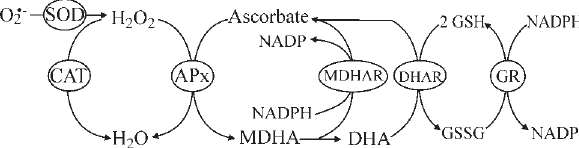
Figure1 -Reactiveoxygenspecies(ROS)scavengingpathwaysinplants. Not all reactions are depicted stoichiometrically. Abbreviation: APx - Ascorbate peroxidase; CAT - Catalase; DHA - Dehydroascorbate; DHAR - Dehydroascorbate reductase; MDHA - Monodehydroascorbate; MDHAR - Monodehydroascorbate reductase; GR - Glutathione reductase; GSH - Reduced glutathione; GSSG - Glutathione disulphide; SOD - Superoxide